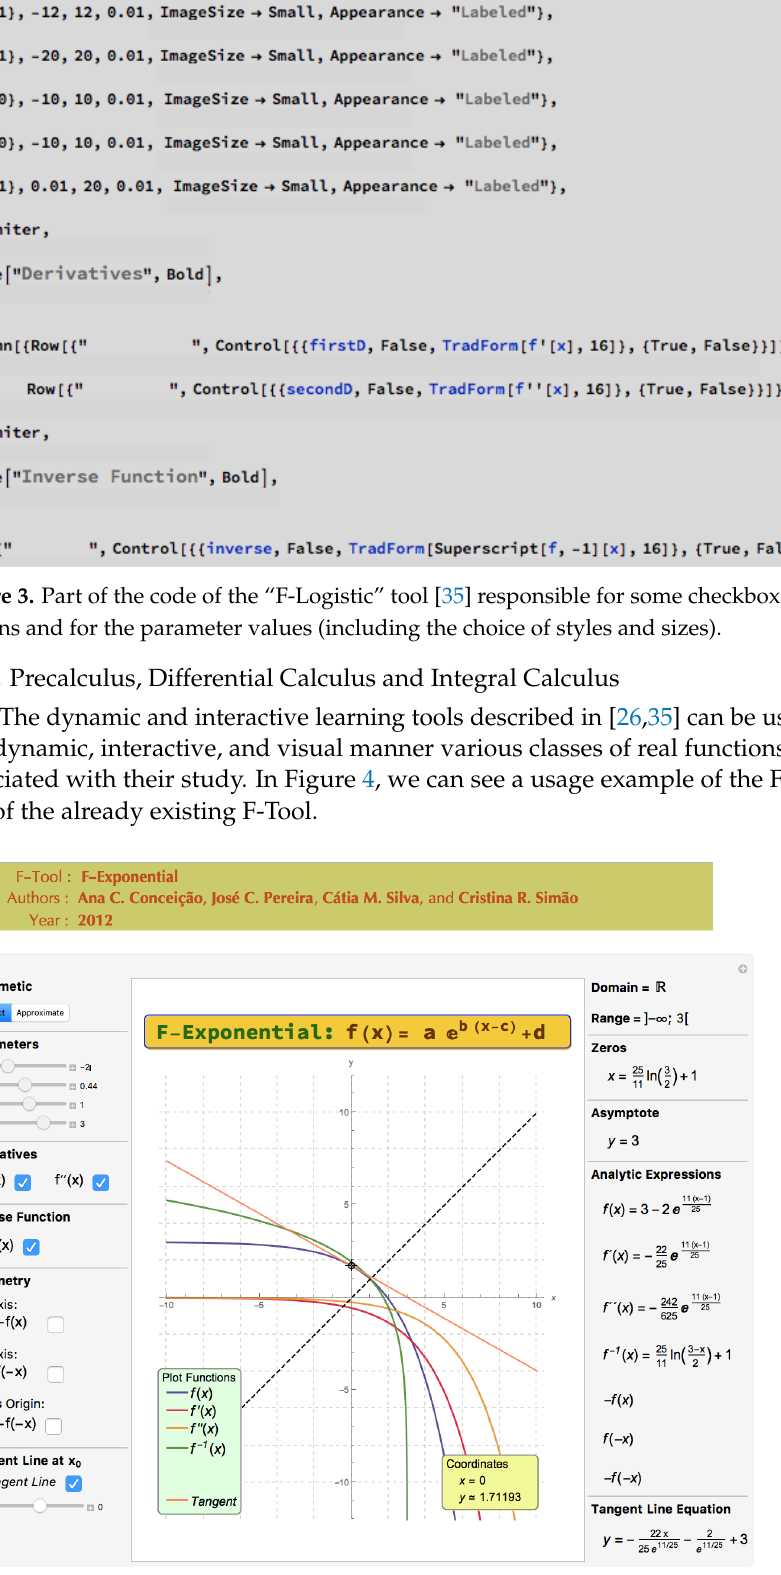
Figure 4. Usage example of the F-Exponential